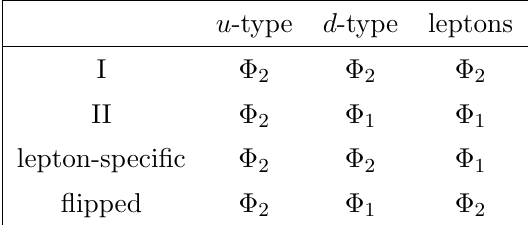
Table 1 . The four Yukawa types of the Z 2 -symmetric 2HDM de(cid:12)ned by the Higgs doublet that couples to each kind of